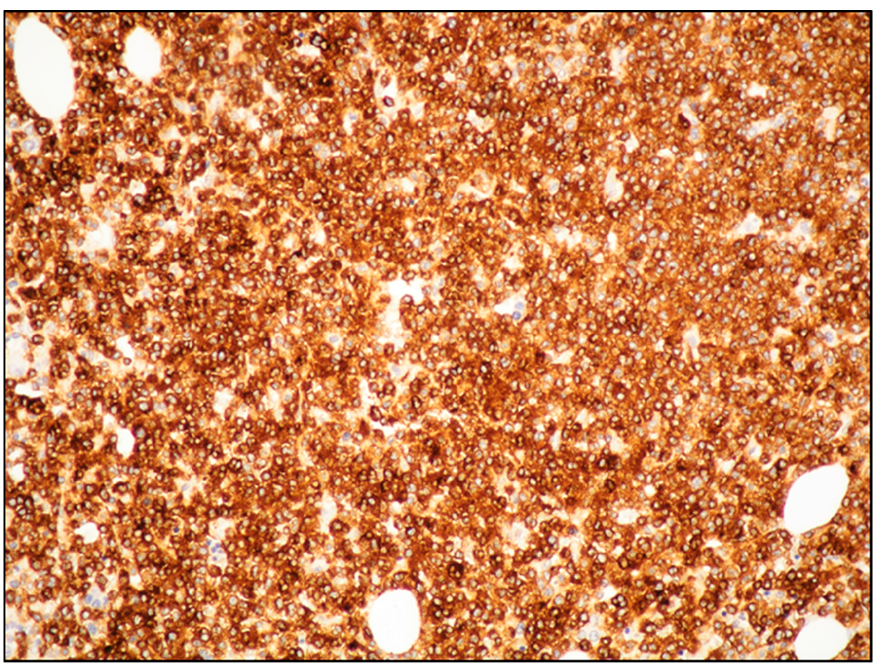
Figure 3. Medium power view of BM infiltrate highlighted by diffuse and intense CD117 positivity (CD117 immunostaining, magnification 100×; original image from Prof. S.A.).